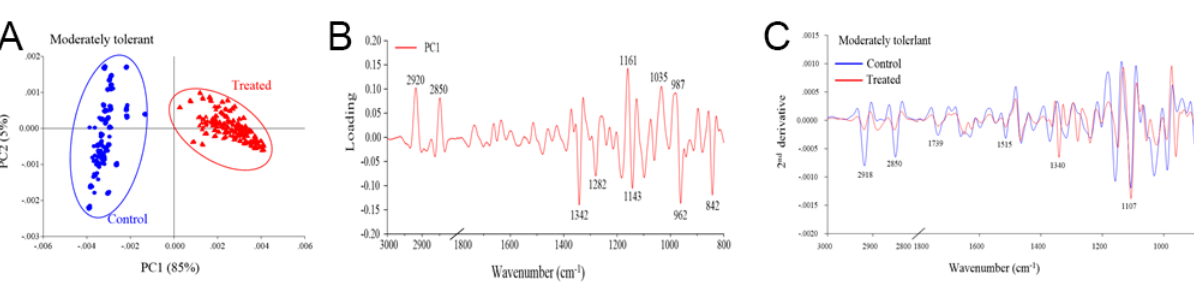
Figure 3 ( A ) Representative PCA score plot of moderately tolerant plants under drought stress conditions and control conditions. ( B ) Loading plot of PC1 from the PCA. ( C ) Second-derivative-transformed spectra. e obtained spectra were analyzed in the regions of 3,000–2,800 cm − 1 and 1,800–900 cm − 1